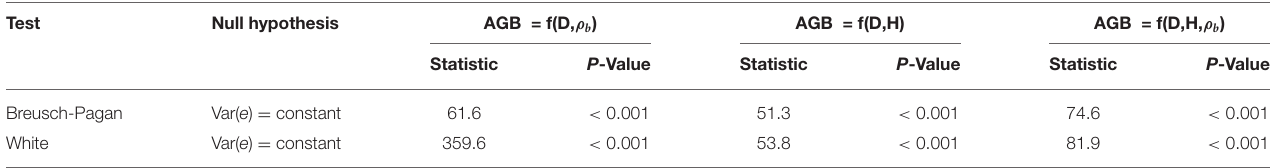
TABLE 4 | Results from the statistical tests applied to the three multivariate